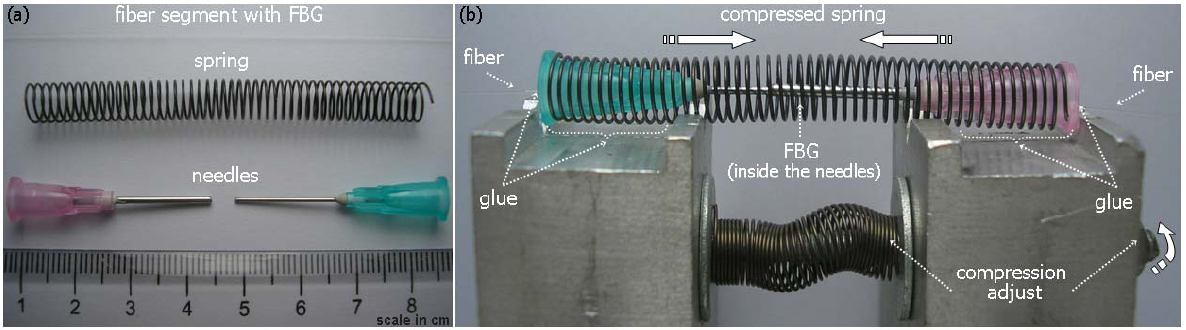
Figure 1. Sensor head construction: (a) elements used to build the sensor head, (b) assembled sensor head installed on the device for gluing and pre-straining the